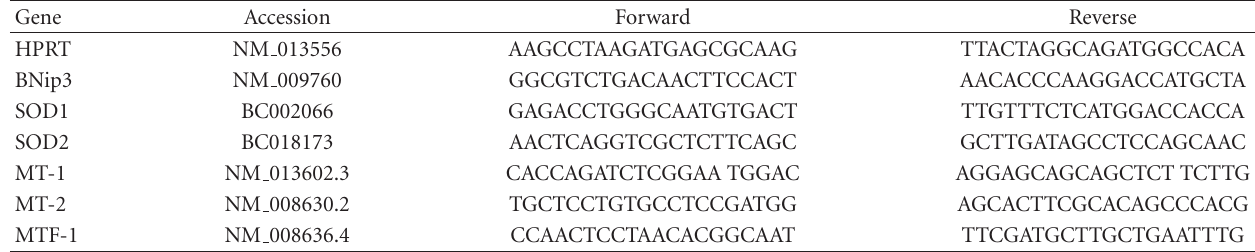
Table 1: qRT-PCR primers.